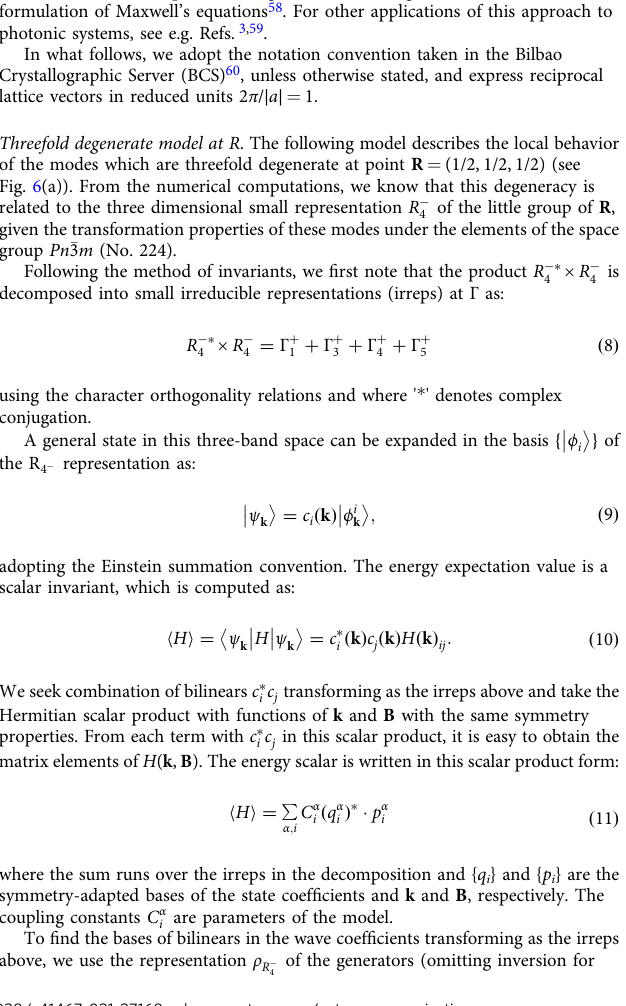
Fig. 5 Topological characterization via Wilson loops. Wilson loops for the system in the Weyl semimetal phase (in blue) and in the cubic 3D C z I phase (in red). Each θ eigenvalue of the WL is related to the WEC in terms of the i -th lattice parameter ∣ a i ∣ by 2 π WEC n , i ≡ ∣ a i ∣ θ n , i , with ∣ a i ∣ = ∣ a ∣ and ∣ a i ∣ = N ∣ a ∣ for the WS and the 3D CI respectively. a , b Individual photonic WECs: fl ow in the k x direction on a selected fi xed k z plane, for each of the bands lying below the local gap. c , d Net photonic WEC fl ow, obtained by summing up the contribution of the individual WECs shown in the above panels: the net winding appears now clearly. Source data are provided as a Source Data fi